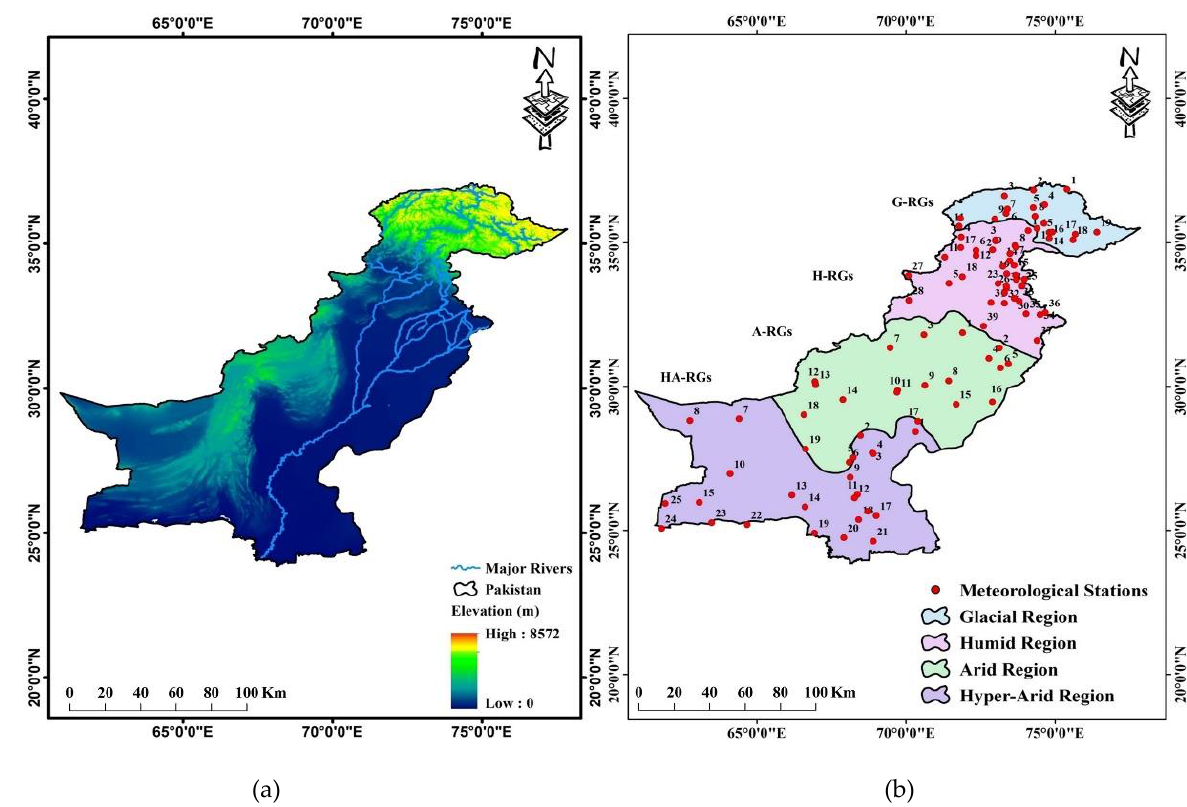
Figure 1. Study area and geographical distribution of meteorological stations (RGs). ( a ) Elevation map retrieved from Shuttle Radar Topography Model (SRTM), and ( b ) Climate regions considered in the current study.